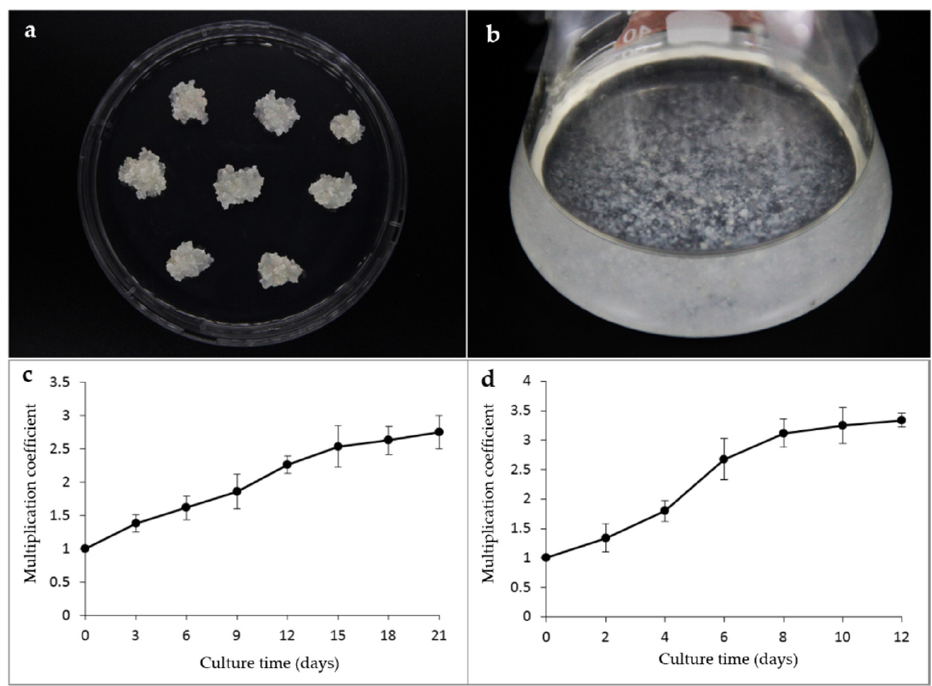
Figure 2. Growth curve of embryogenic lines in two proliferation ways. ( a , c ) Proliferation in semi- solid medium. ( b , d ) Proliferation in liquid medium.